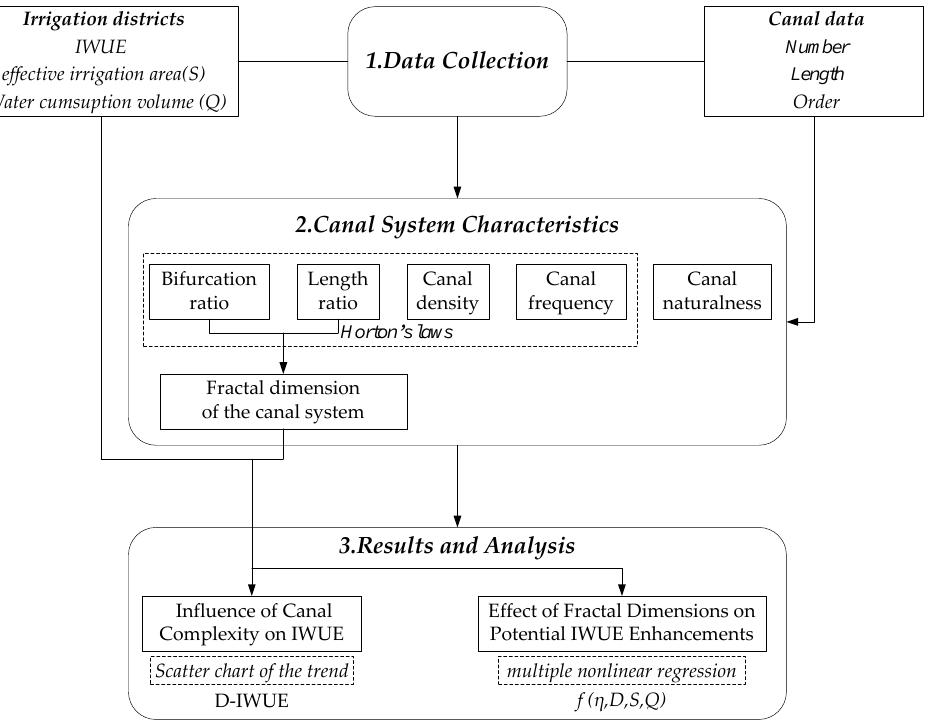
Figure 2. The diagram of methodology. IWUE— irrigation water use efficiency.